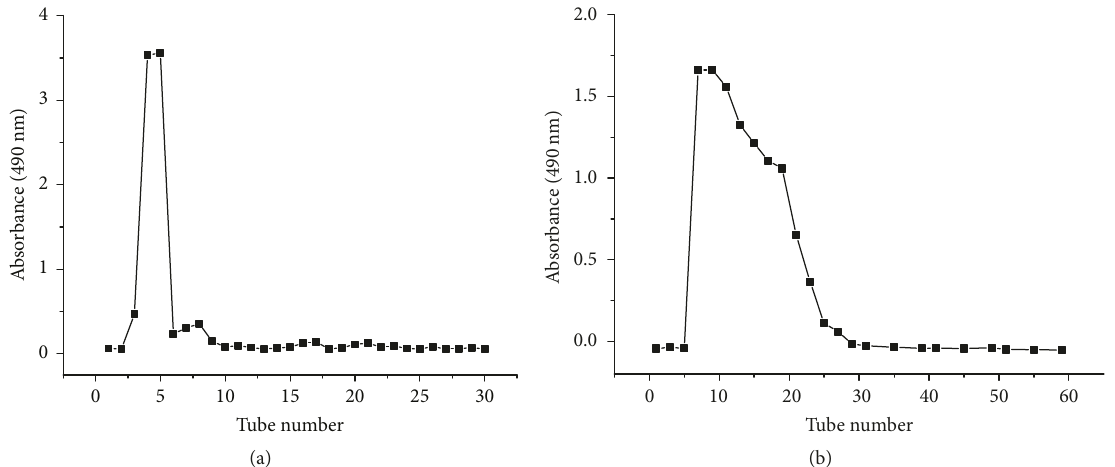
Figure 1: H 2 O elution curve of crude polysaccharide with DEAE-FF chromatography (a) and CJP1 with Sephadex G-100 column (b).